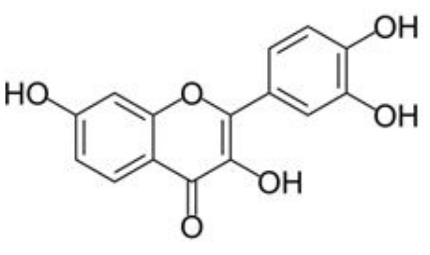
Figure 1: Fisetin structure. Fisetin consists of two phenyl rings and one heterocyclic ring with hydroxyl groups on C3, C7, C3′,